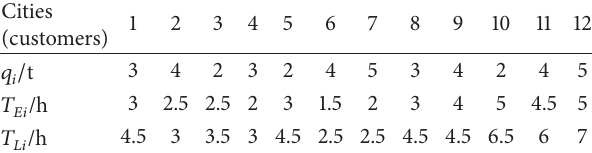
Table 4: Demand for cities and time window request.